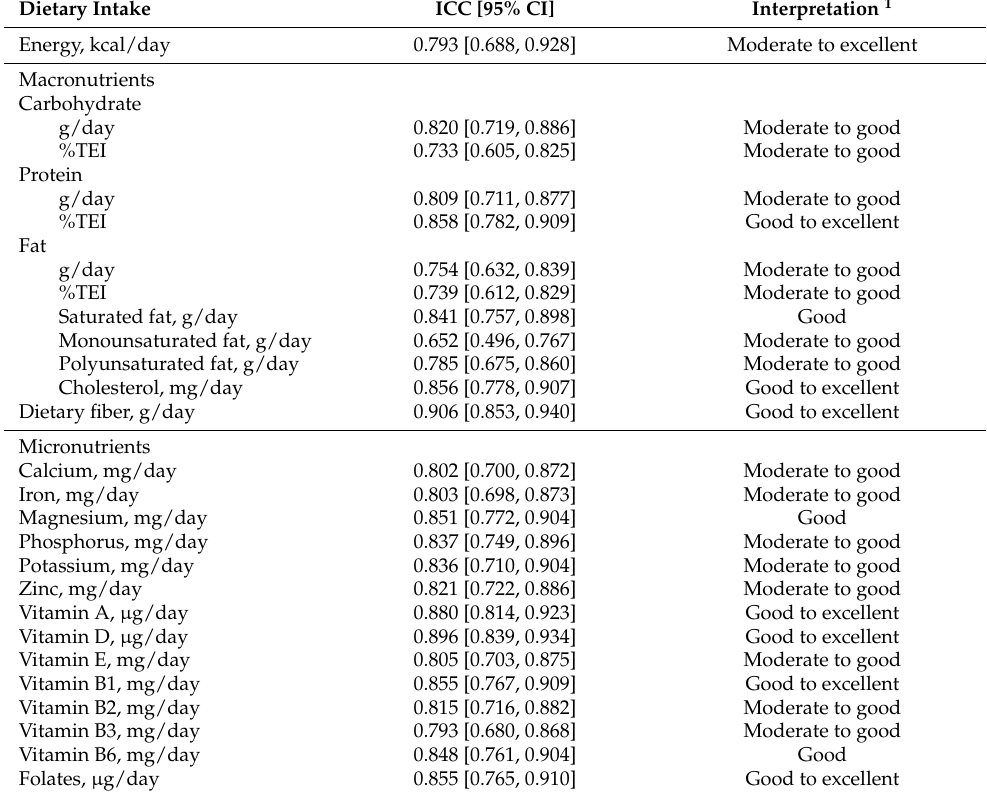
Table 4. Summary of intra-class correlation coefficient (ICC) to assess the reliability of Remind